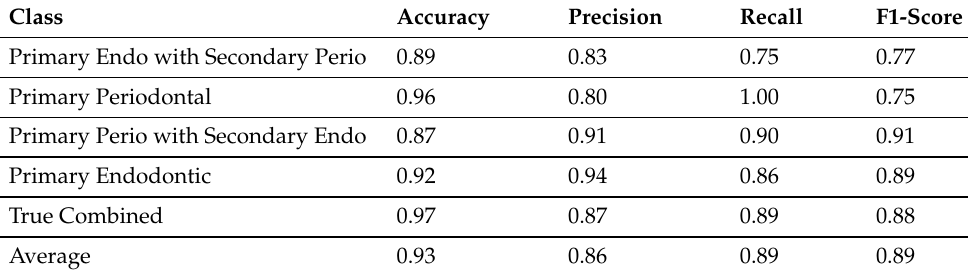
Table 4. Comparison of performance indicators for each disease.